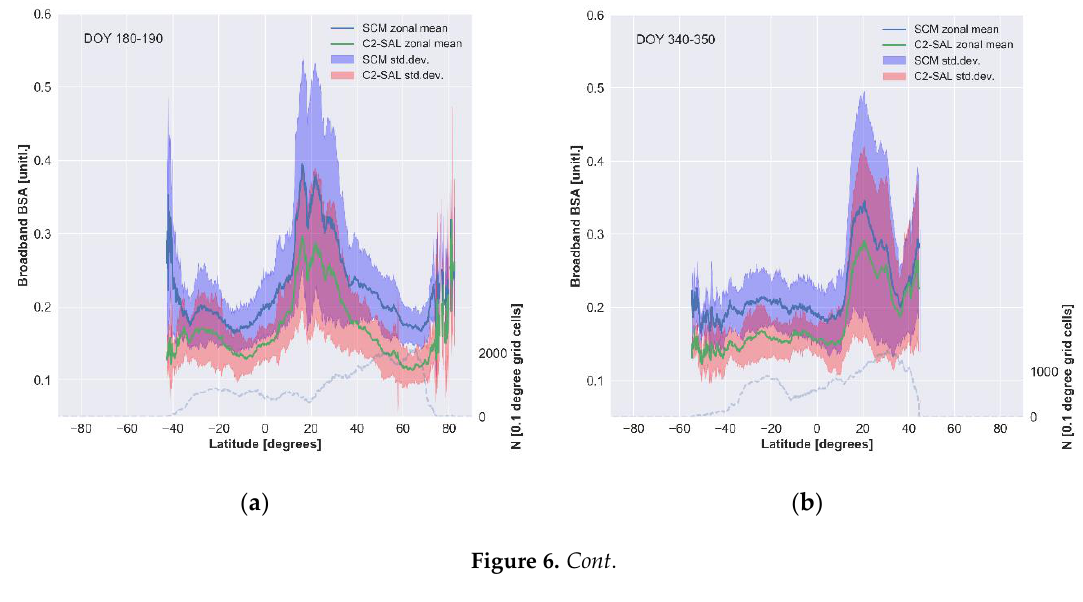
Figure 5. The zonal means of SCM and reprojected MCD43D broadband black-sky albedo (BSA) albedo estimates for ( a ) SCM DOY 180 – 190 versus MCD43D centered on DOY 185, ( b ) the SCM DOY 340 – 350 versus MCD43D centered on DOY 345, and ( c ) the time-latitude 3D representation of the difference in zonal means across the analyzed six months of the SCM data in 2010. Zonal means calculated from the grid cells where both SCM and MCD have calculated full BRDF inversions. The maroon color indicates the overlap of SCM and MCD43 albedo standard deviation within a 0.1-degree latitude band. The dashed line in subplots (a) and (b) indicate the number of valid grid cells for the calculation of each zonal mean (secondary